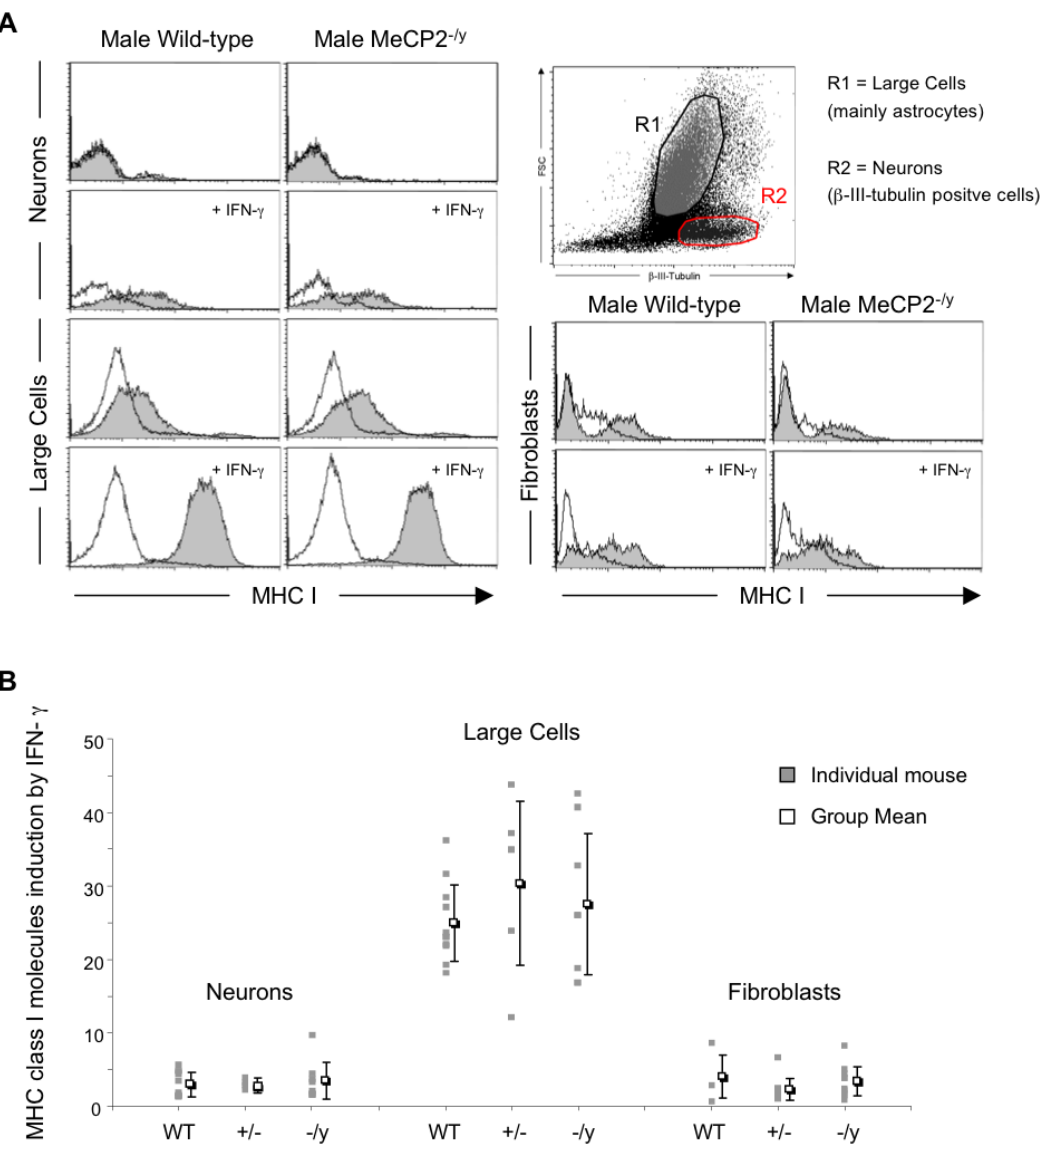
Figure 5. Deletion of MECP2 does not affect basal or IFN- c -induced MHC class I expression in primary cultures of mixed glial cells. Mixed glial cell cultures established from two-day old wild-type, MeCP2 + / 2 and MeCP2 2 /y mice (10, 6 and 8 animals per group, respectively) were treated or not with IFN- c on the second day of culture and analysed two days later by flow cytometry for MHC class I expression. Neurons were identified by their intracellular staining with an anti- b -III-tubulin antibody (inset). Large cells, containing mainly astrocytes, were analysed separately by an appropriate forward/side scatter gate. Primary spleen fibroblasts from the same mice were also subjected or not to IFN- c treatment and stained for their MHC class I expression. Panel A: Representative histograms showing cell surface staining (x axis) against cell number (y axis), obtained with cells from wild- type and MeCP2 2 /y male littermates. White-filled curves represent background staining, gray-filled curves represent MHC I-specific staining. Panel B: MHC class I fold-induction in response to IFN- c was calculated as the ratio of MFI of treated cells (induced MHC I level) on MFI of untreated cells (basal MHC I level). Grey-filled squares show MHC class I fold-induction for individual mice and for each cell type. White-filled squares represent the group’s mean of fold-inductions ( 6